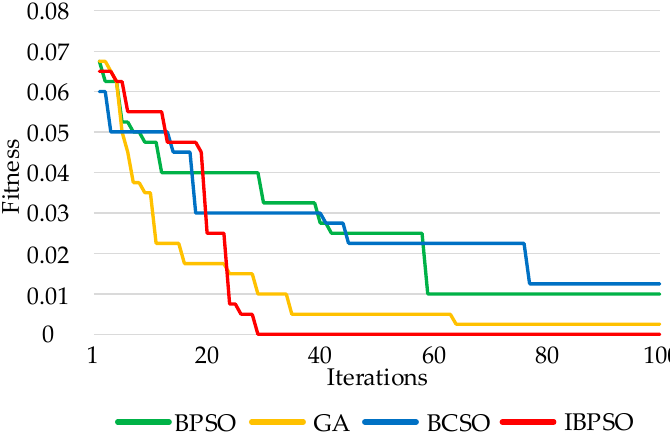
Figure 4. Comparison between IBPSO based on convergence curves of CWRU bearing dataset. Table 10. Details of obtained optimal feature Table 9. Comparison between IBPSO based on fitness value and number of selected features in this case study.